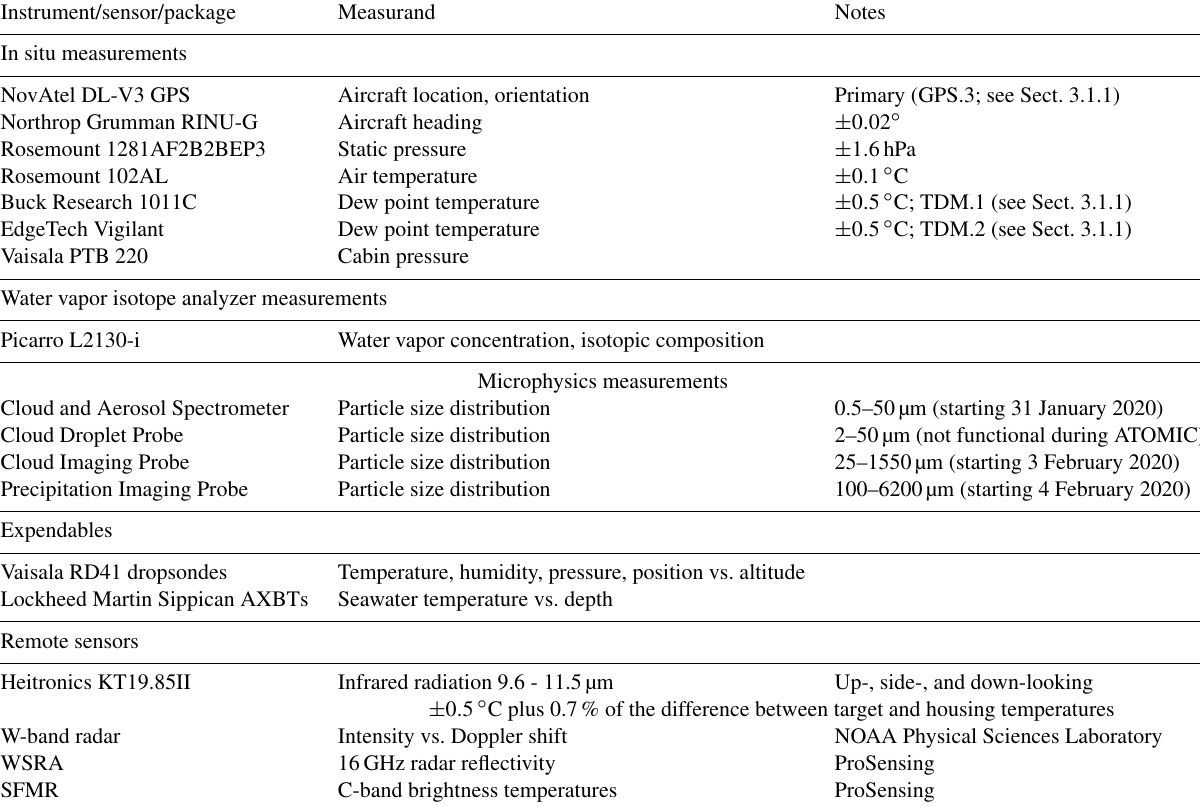
Table 2. Instrumentation aboard or deployed from the P-3 aircraft during the ATOMIC field campaign. Most instruments are the same or similar to those used during hurricane reconnaissance and other scientific missions, though the water vapor isotope analyzer and W-band radar were deployed specifically for this field campaign. See also Table A5 in Stevens et al.